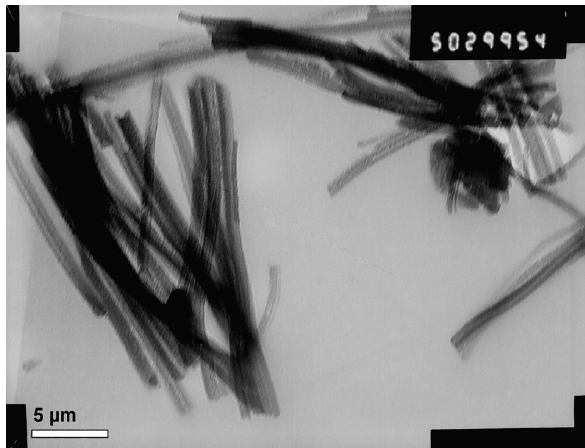
Figure 4: TEM of silicon oxide nanofibers.